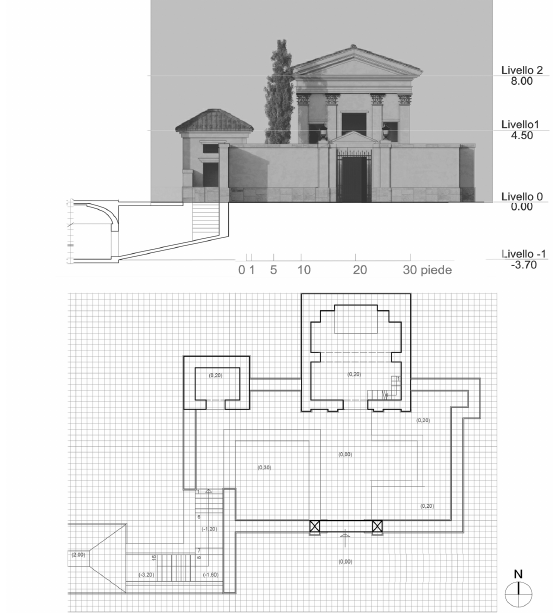
Figure 6b. Aedificium custodiae (b) . Use of the grid to compare the proportions of the west elevation with the adjacent ones of the temple and with the reconstructions of rustic